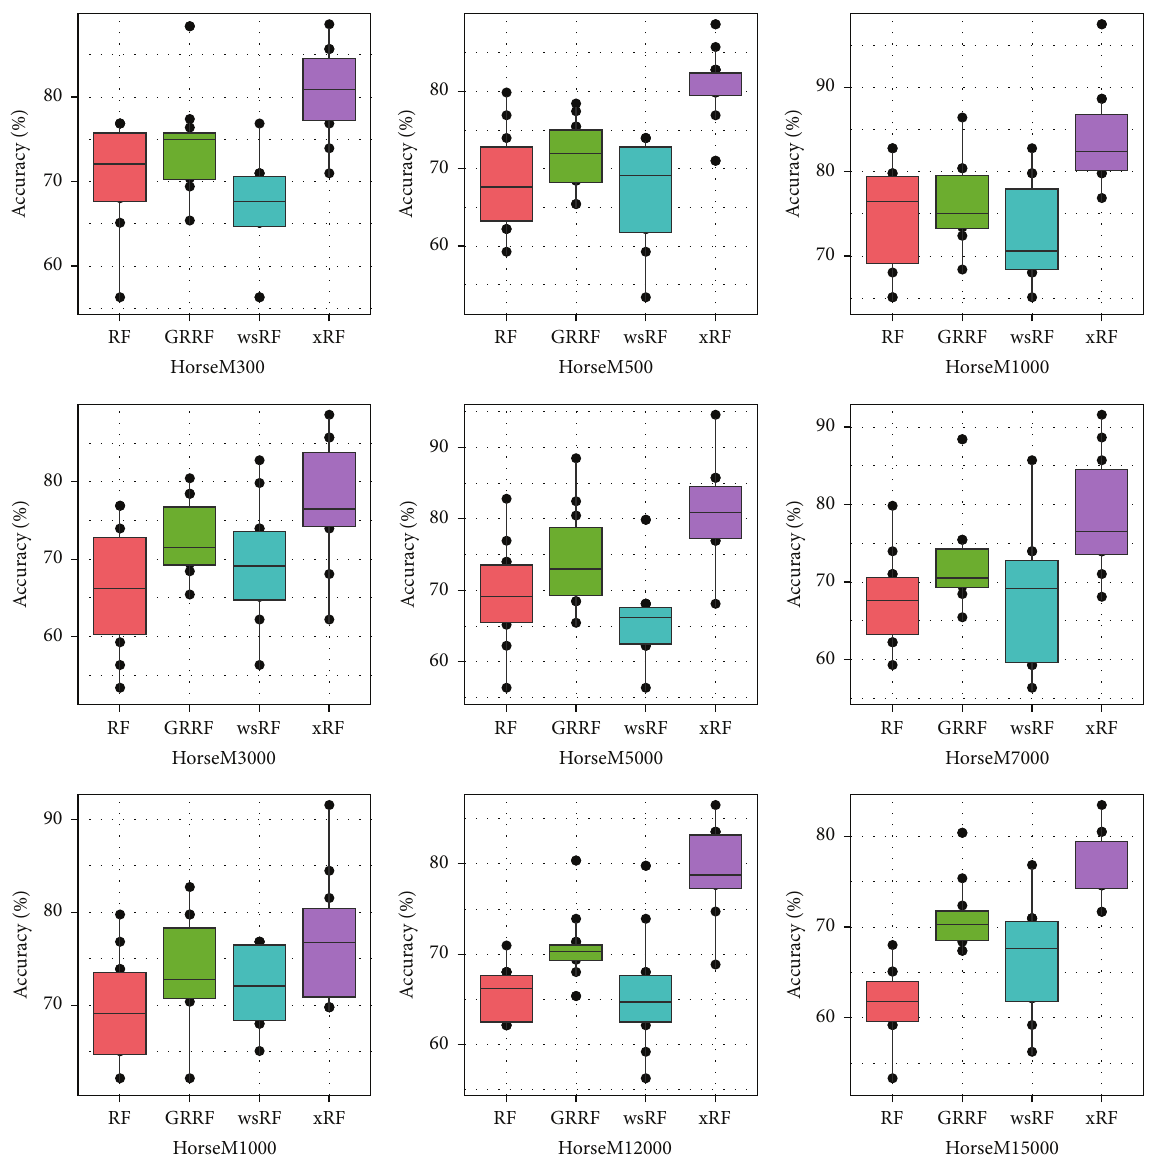
Figure 5: Box plots of the test accuracy of the nine Horse